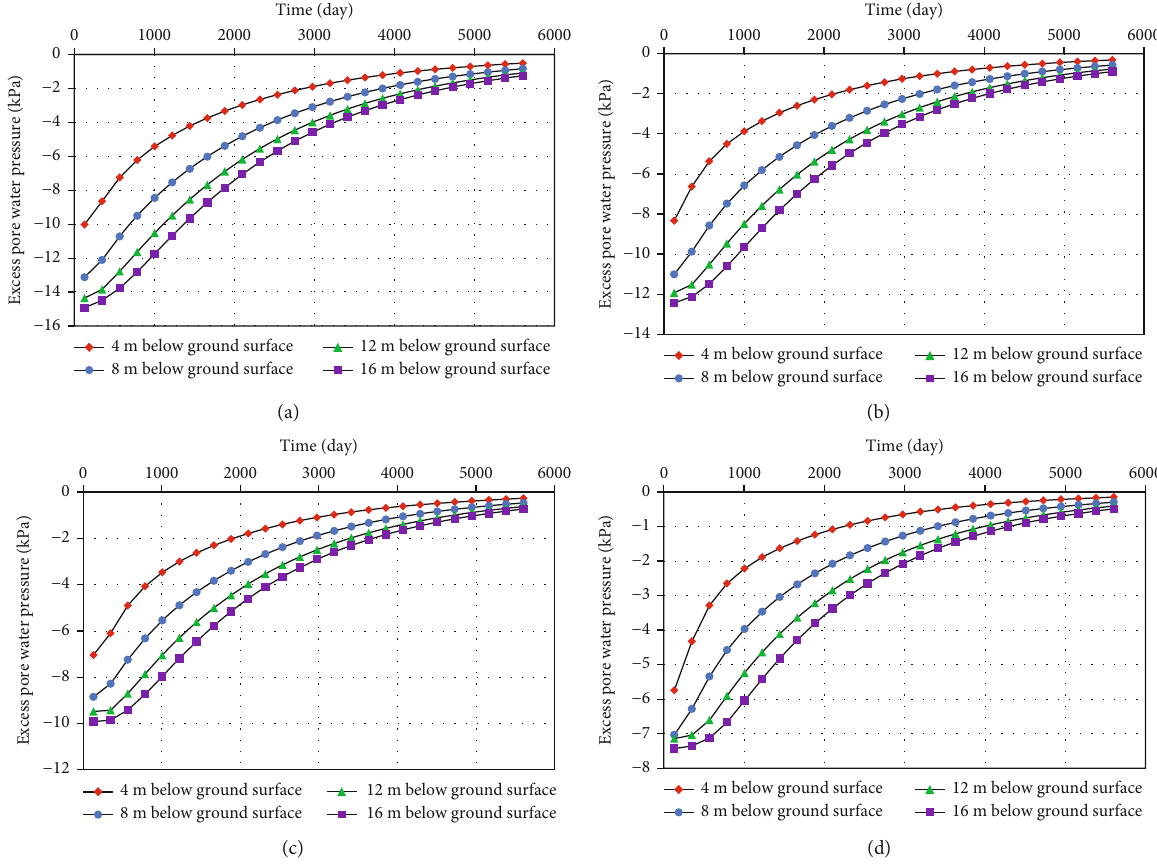
Figure 15: Excess pore water pressure-time curve in soft soil under slope toe with the replacement thicknesses of (a) 1.5 m, (b) 2.0 m, (c) 2.5m, and (d)